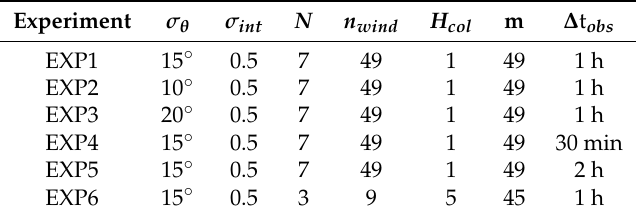
Table 1. Set of experiments performed to test the assimilation procedure. σ θ is the standard deviation of the perturbation in wind direction that we imposed to create the perturbed wind-fields, while σ int is the standard deviation of the perturbation in horizontal wind intensity. For all the experiments, µ θ = 0 ◦ and µ int = 1. N is the number of percentiles that we considered from each Gaussian distribution (direction and intensity) and n wind indicates the total number of perturbed wind-fields used to create the ensemble members ( n wind = N 2 ). H col is the number of hypothetical column heights from which ensemble members are created. m is the product of n wind by H col and indicates the number of members forming the ensemble. ∆ t obs specifies the sampling time interval for the satellite observations to be considered in the assimilation procedure. Experiment σ